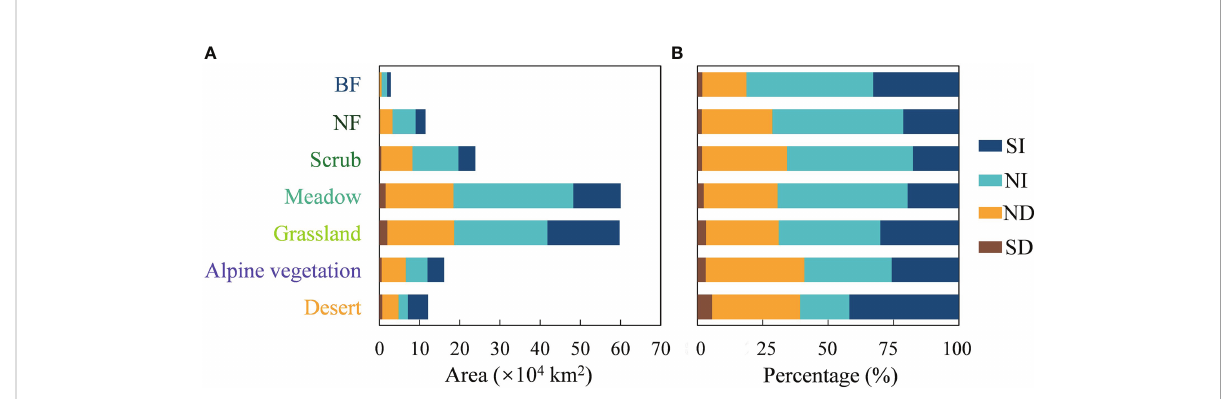
FIGURE 5 Area statistics of greenness change for seven vegetation types on the Qinghai-Tibet Plateau. (A) Area and (B) percentages of SI, NI, ND and SD for seven vegetation